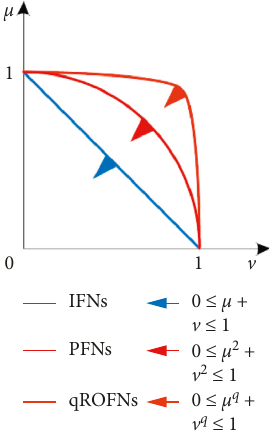
Figure 3: The relationships among IFNs, PFNs, and